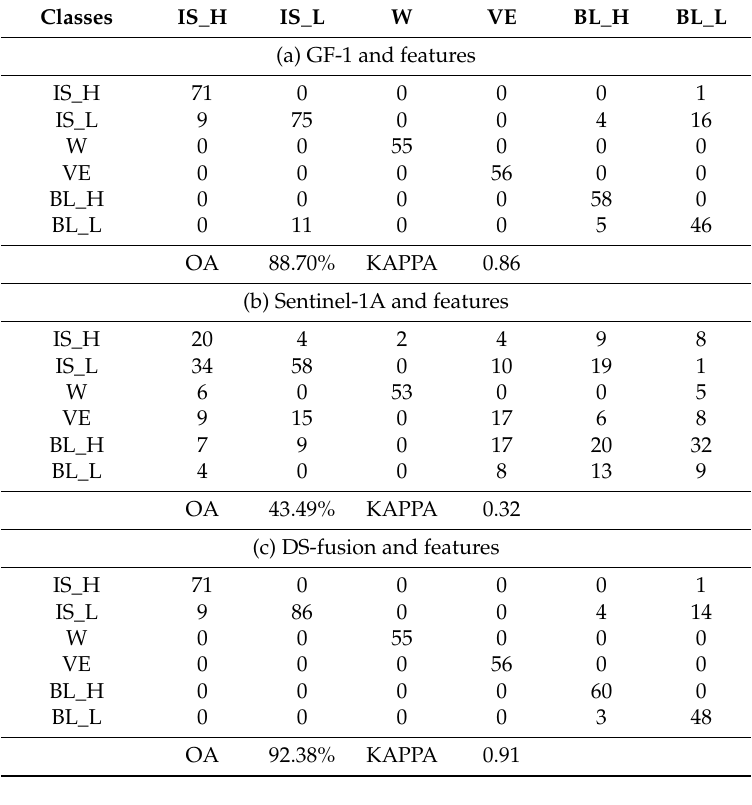
Table 4. The confusion matrix and accuracy assessment for land cover classification by using the GF-1 image and its spectral features/the Sentinel-1A image and its texture features/fusing the GF-1 and Sentinel-1A images and their features.